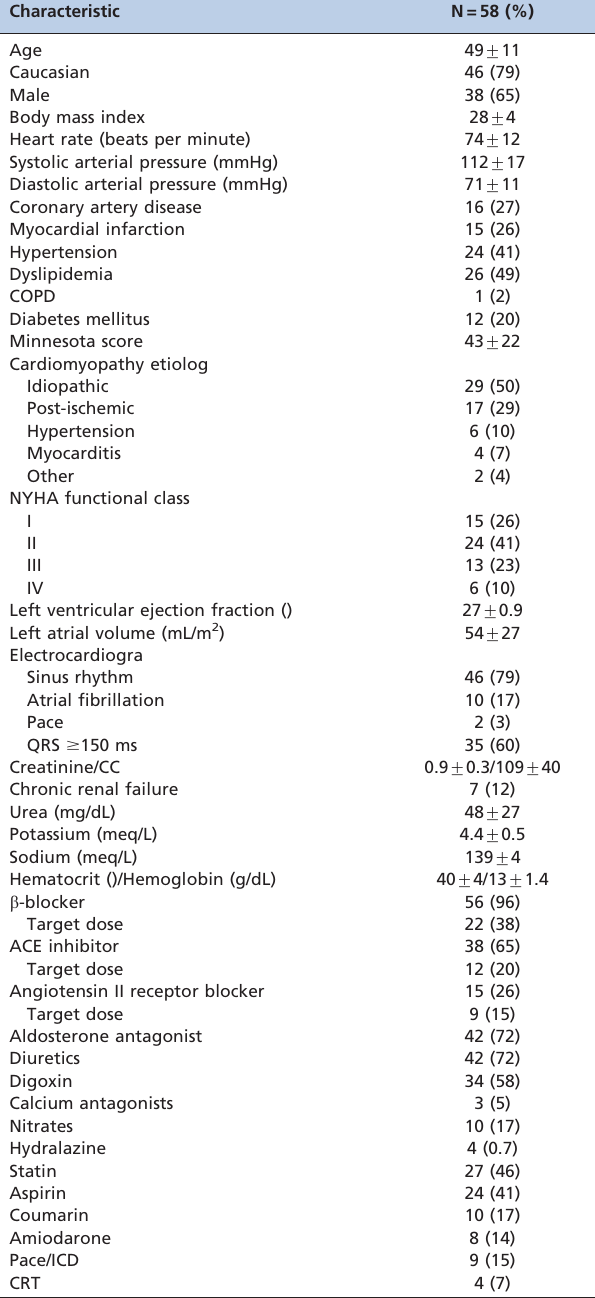
Table 1 - Primary patient characteristics.